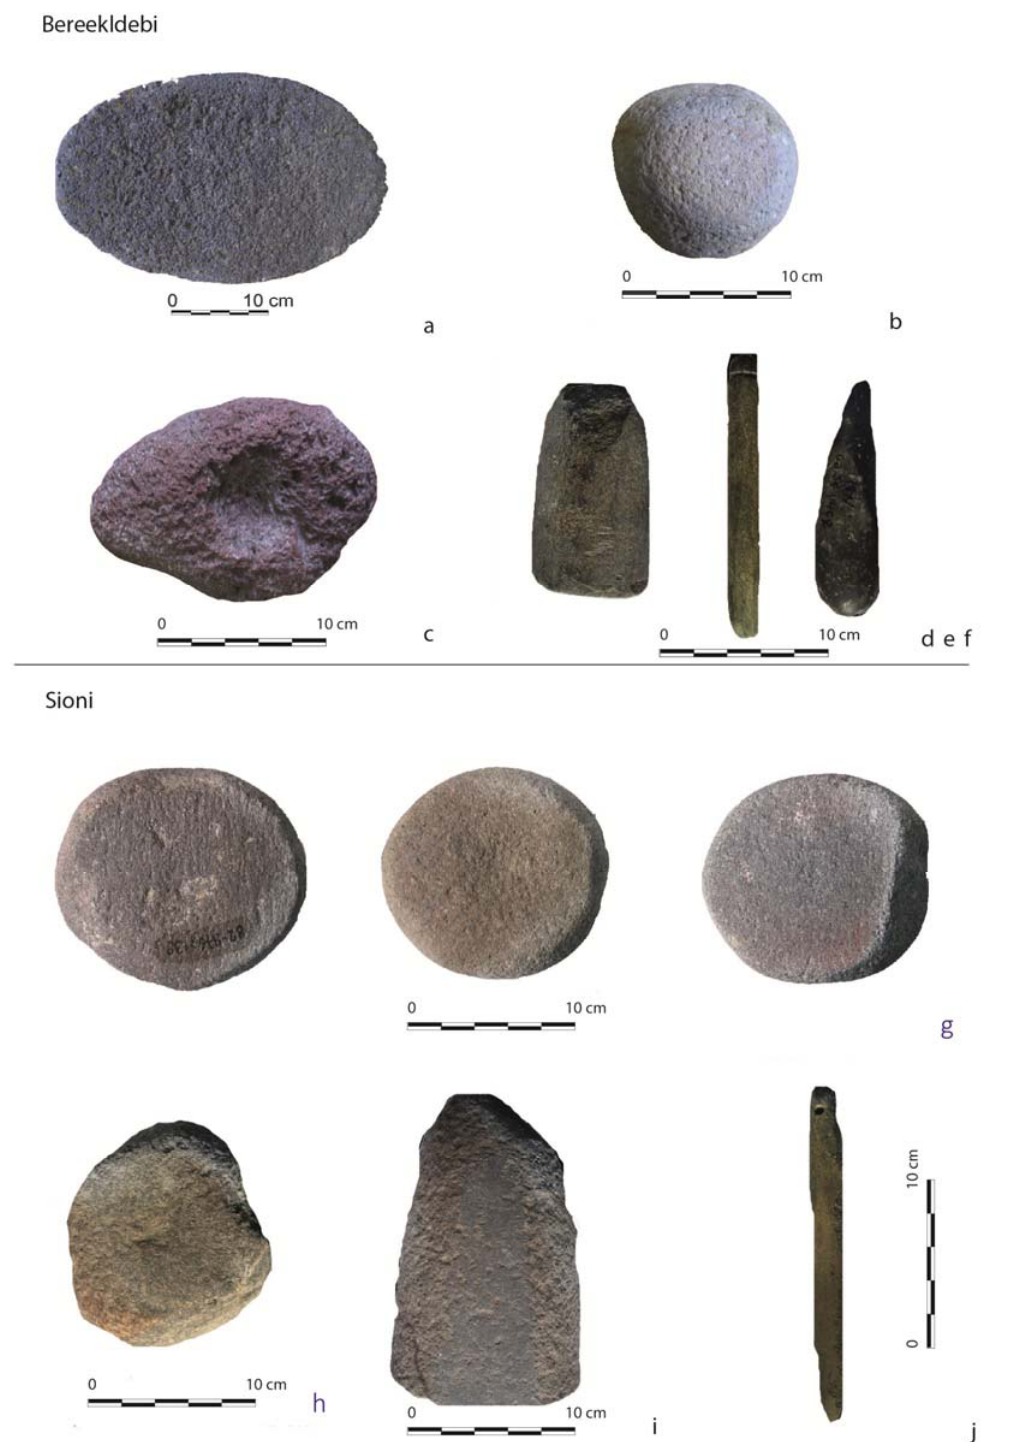
Figure 6. Chalcolithic macrolithic implements. Bereekldebi: a. grinding tool; b. small spherical grinder- hammerstone; c. Crusher; d. Pestle; e. sharpener; f. burnisher. Sioni g. serie of small grinder-crusher for mineral matters processing; h. hammerstone-crusher; i. pestle; j. sharpener (photographs by C.